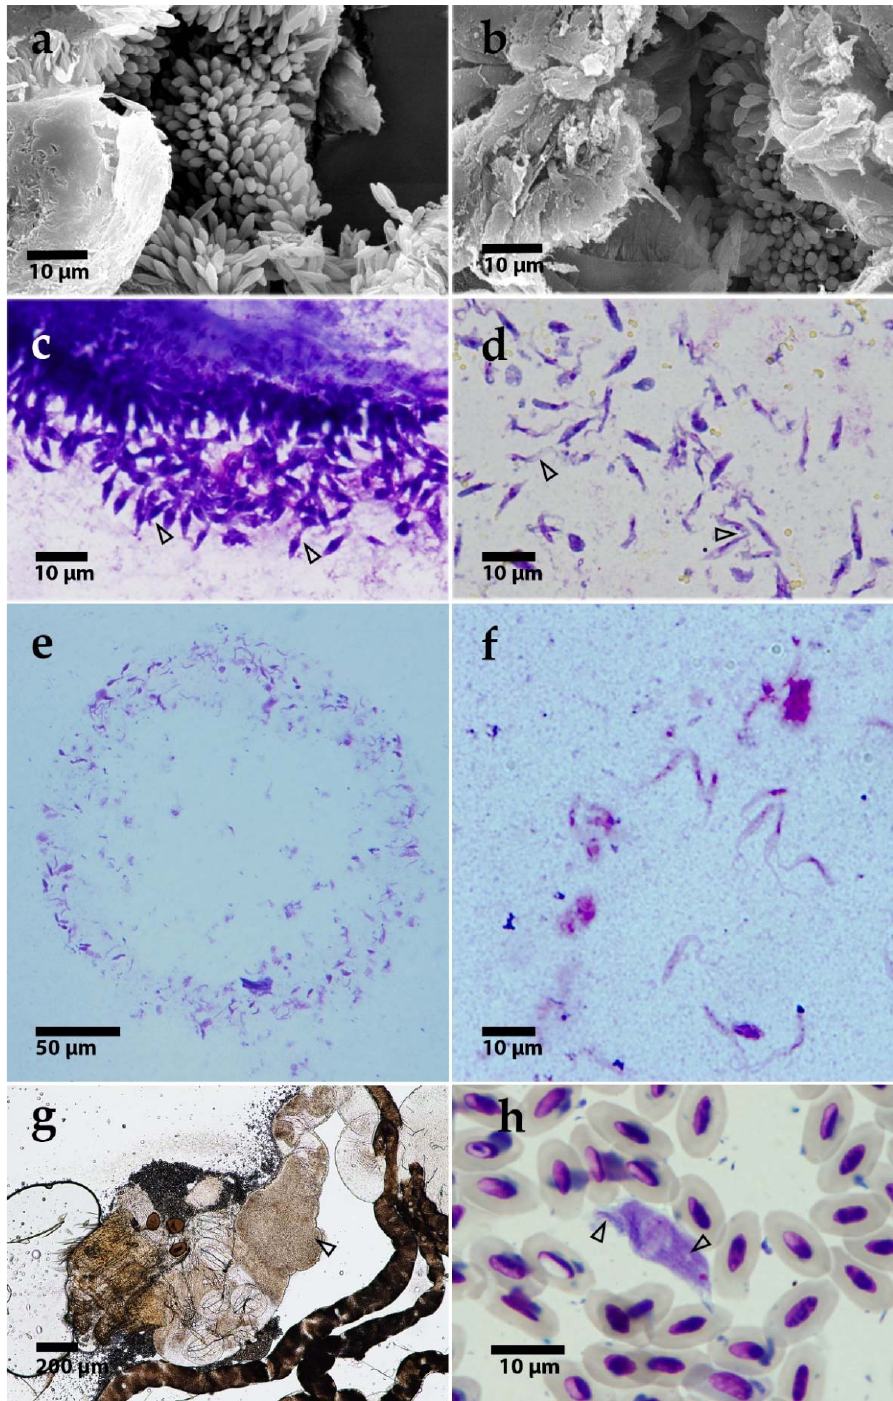
Figure 3. ( a , b ) Scanning electron microscopy of T. thomasbancrofti OF19 ( a ) and PAS343 ( b ) in the gut of Culex quinquefasciatus after experimental infection ( c , d ). Light microscopy of trypanosome morphotypes in Culex quinquefasciatus gut: rosettes ( c ) and epimastigotes ( d ). Prediuresis droplet with numerous trypanosomes (CUL98) ( e ). A detail of epimastigotes from prediuresis droplet ( f ). Dissected Culex mosquito gut with trypanosomes after xenodiagnosis; arrowhead pointing to the mass of parasites ( g ). T. thomasbancrofti trypomastigote from barn swallow ( Hirundo rustica ) blood with visible striation (see arrows for striation) ( h )